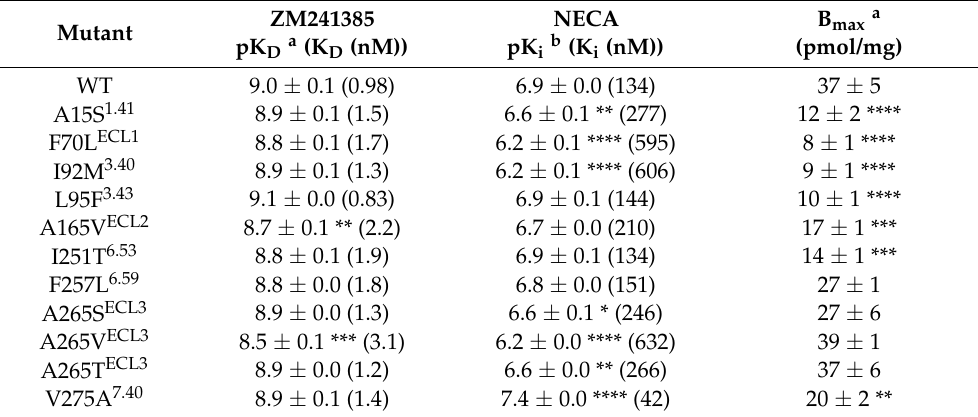
Table 1. Affinity values of ligands for wild-type (WT) and mutant A 2A ARs and their expression levels (B max